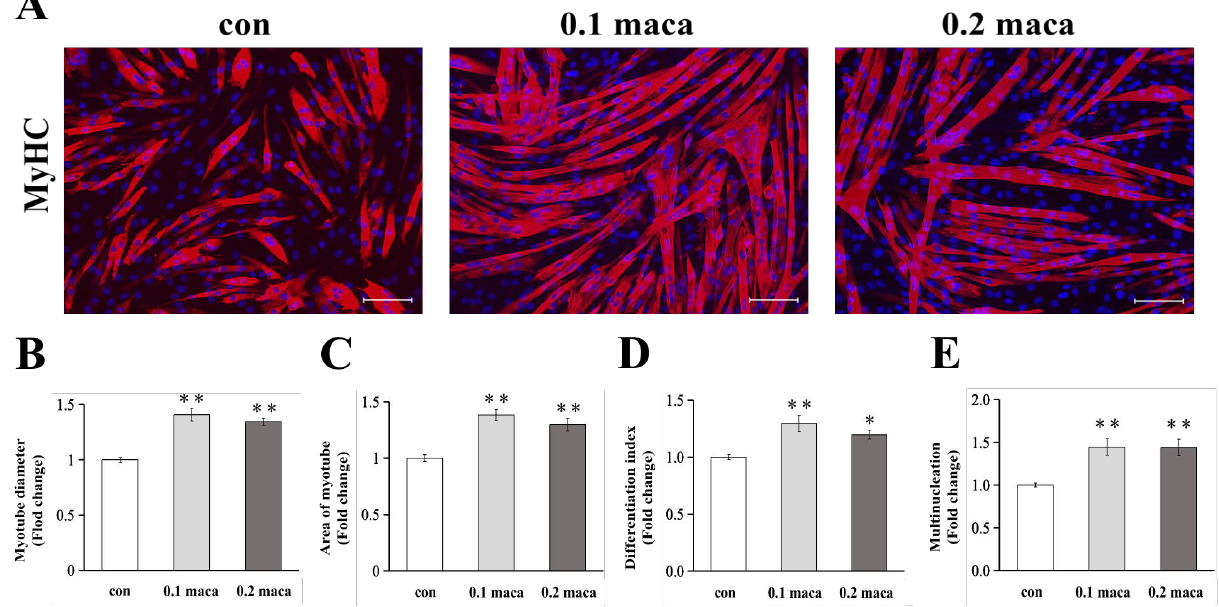
Figure 1. C2C12 myotubes were immunostained with myosin heavy chain (MyHC; red), and the nuclei were immunostained with DAPI (blue). Scale bar: 100 μm. Representative images were taken ( A ). Two independent experiments (n = 7) showed the same trend in myotube diameter ( B ), myotube area ( C ), differentiation index ( D ), and Multinucleation ( E ). * p < 0.05 vs. con; ** p < 0.01 vs.